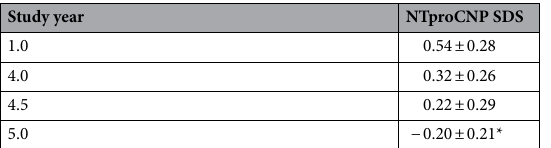
Table 2. Effect of 15 µg/kg/day Vosoritide on mean NTproCNP SDS after 1–5 years of therapy (n = 17). *Significant difference from year 1 (P = 0.015).